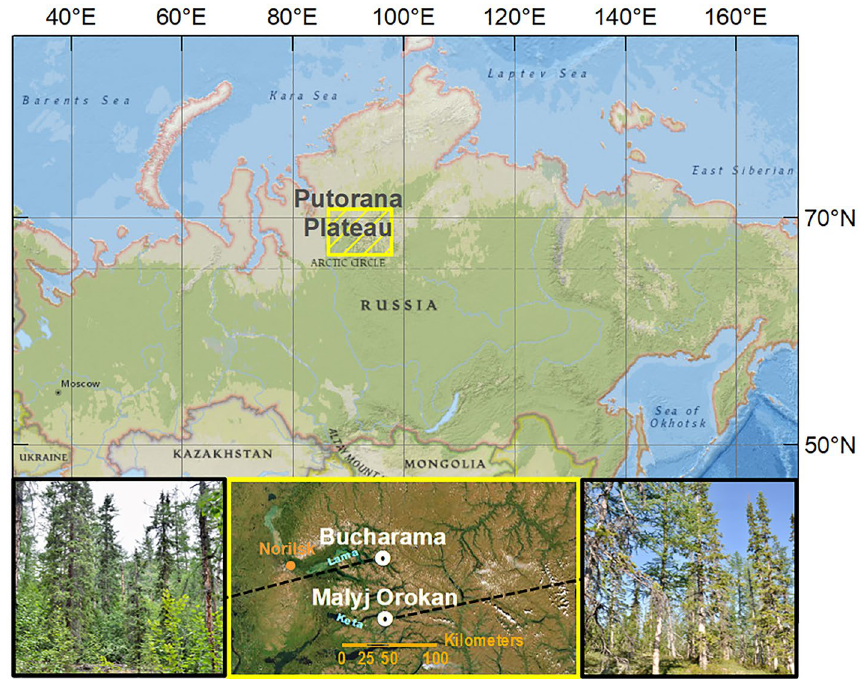
Figure 1. Position of the Bucharama and Malyj Orokan valleys intersecting the Putorana Plateau. The map was created using ArcGIS 10.2 © 1995–2022 ESRI Inc., licensed under the Esri Master License Agreement